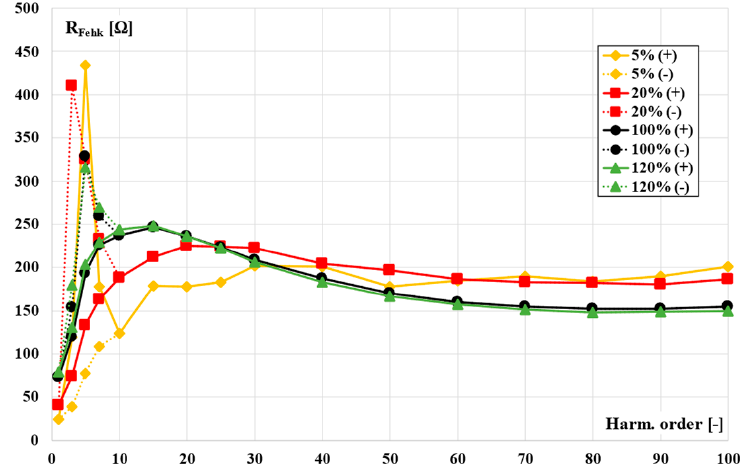
Figure 8. The change, with the frequency of the transformed harmonic, of the resistance representing the active power losses in the magnetic core of a 100 A/5 A CT.